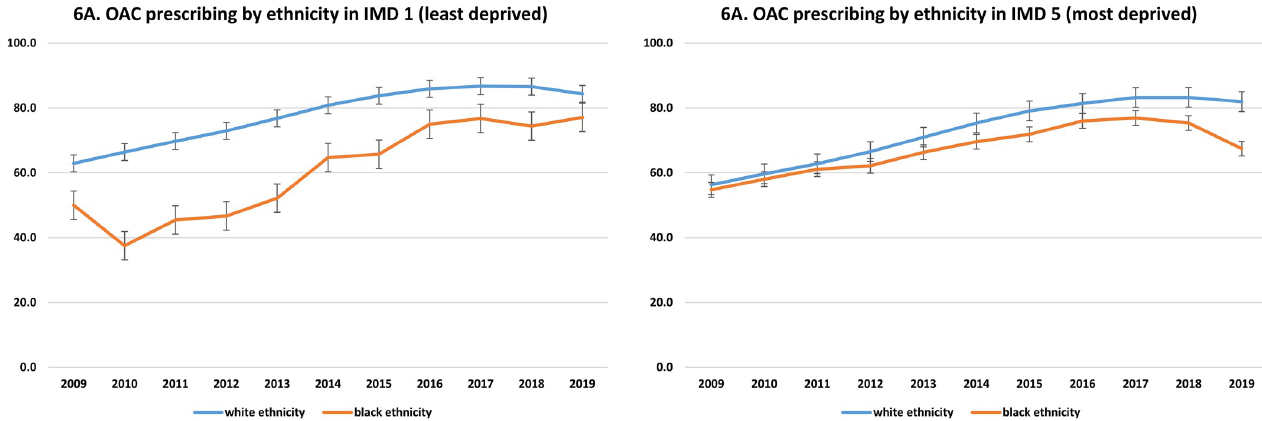
Fig 6. Trend in OAC prescribing over time by ethnicity and deprivation quintile, estimated as proportions and 95% CI. CI, confidence interval; IMD, index of multiple deprivation; OAC, oral anticoagulant.